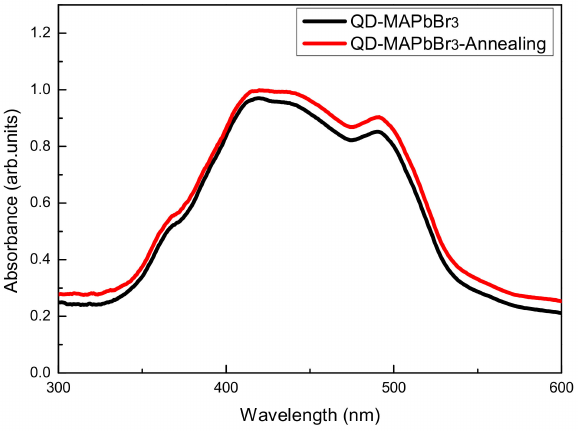
Figure 7. Absorption spectra of the QD-MAPbBr 3 films with and without annealing